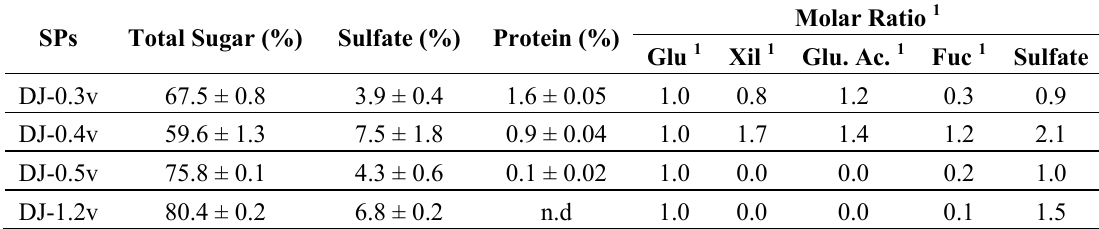
Table 1. Chemical analysis and molar ratio of the sugar and sulfate content of Sulfated Polysaccharides extracted from the Brown Seaweed Dictyopteris